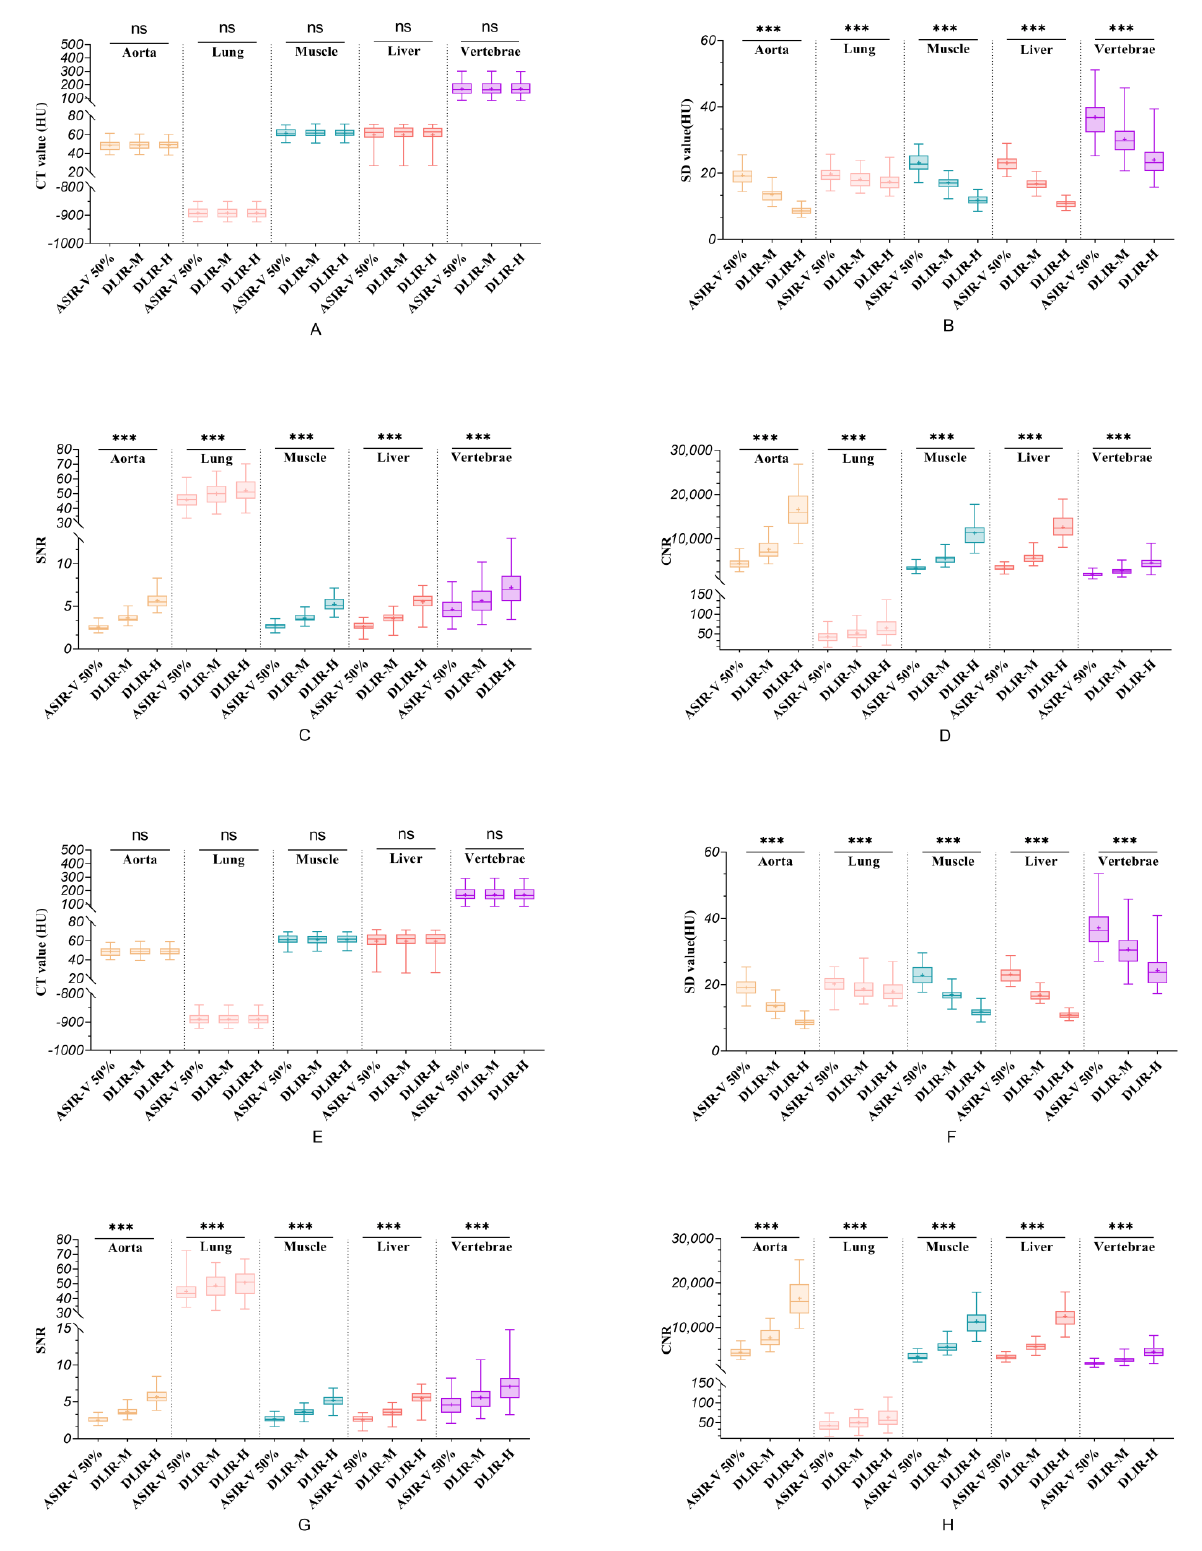
Figure 1. Boxplots of all quantitative data. ( A − D ) show the CT value, SD value, SNR, and CNR measured by Reader 1, respectively. ( E − H ) show the CT value, SD value, SNR, and CNR measured by Reader 2, respectively. ns indicates that the difference between the three groups is not statistically significant ( p > 0.05). *** indicates that the difference between the three groups is statistically significant ( p < 0.001). + in the boxplot indicates the mean